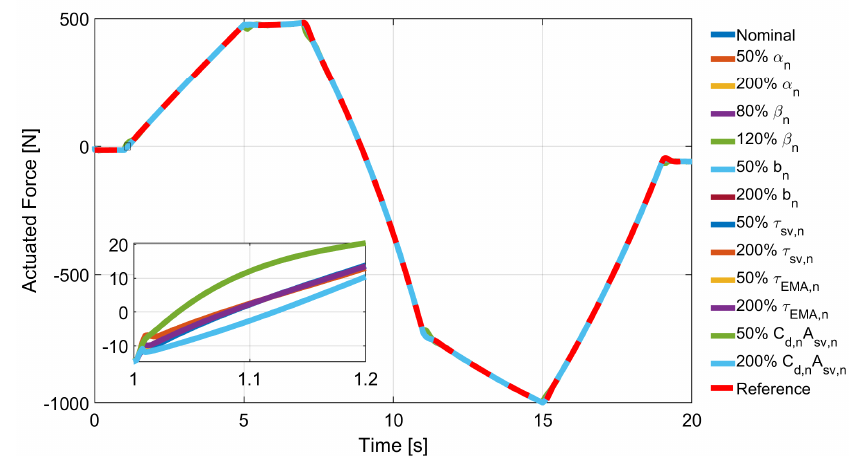
Figure 20. Simulation #3: Actuated Force compared to the reference